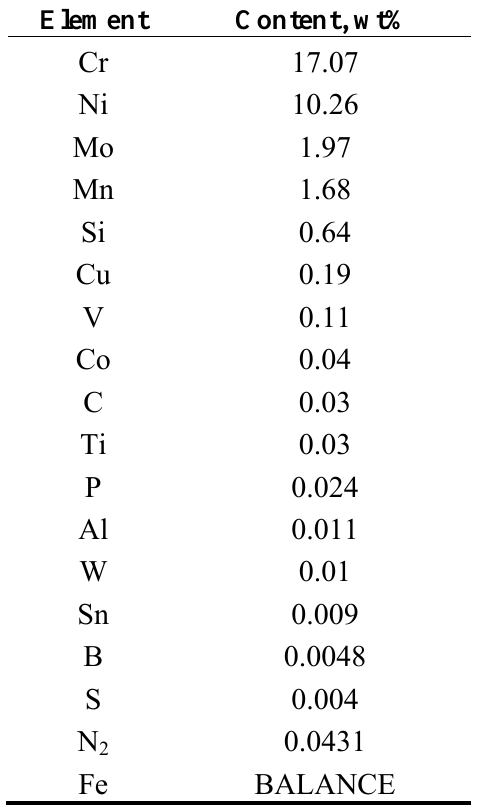
Table 1. Chemical composition of AISI 316L SS used for the experiments